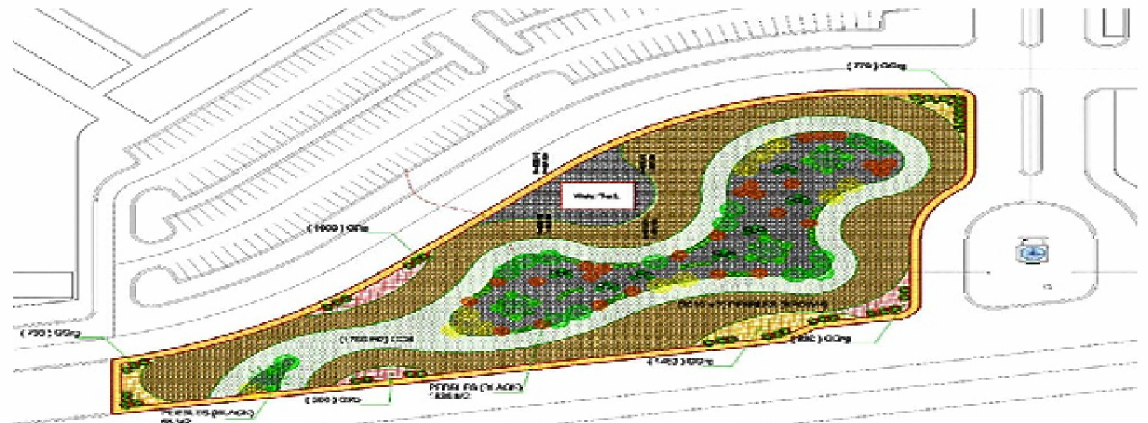
Figure 9. The previous situation for Gate 11 landscape area. Previous tender softscape design (Details of water consumption is shown in Table A3).